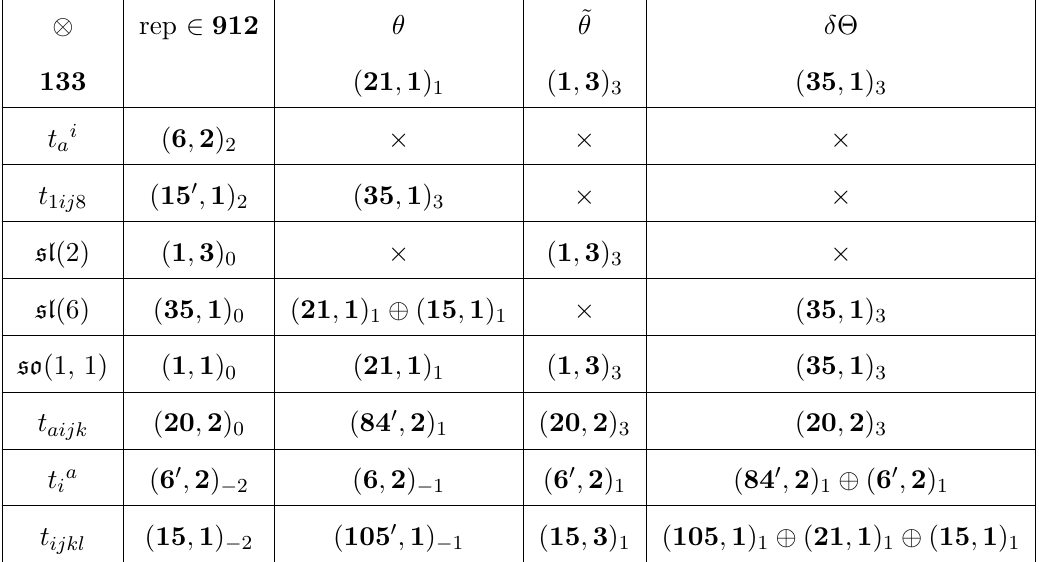
on the 912 using the SL (6) × 7(7)